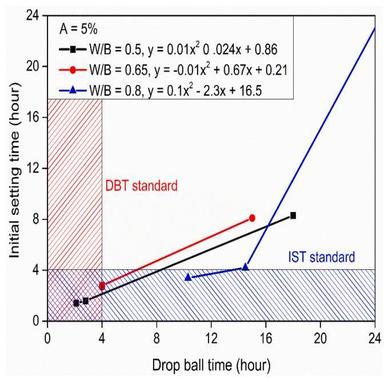
Relationship between DBT and IST in CLSM with a constant A of 5%.